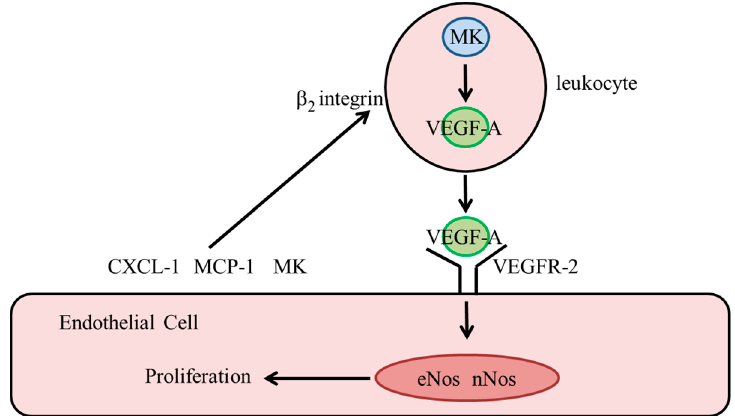
Figure 3. Proposed model for the mechanistic function of MK in regulating vascular endothelial cell proliferation in arteriogenesis. During recruitment, leukocytes get in close contact with the endothelial cell surface, which is covered with CXCL-1, MCP-1 and MK. Upon integrin β 2 activation, VEGF-A is increased, expressed, and released from leukocytes. However, not only MK stored on endothelial cell surface, but also MK stored in leukocytes might contribute to increased bioavailability of VEGF-A. Upon binding to VEGFR2, VEGF-A promotes the expression of eNOS and nNOS relevant for endothelial cell proliferation. Adapted from Lautz et al. 2018 [76].